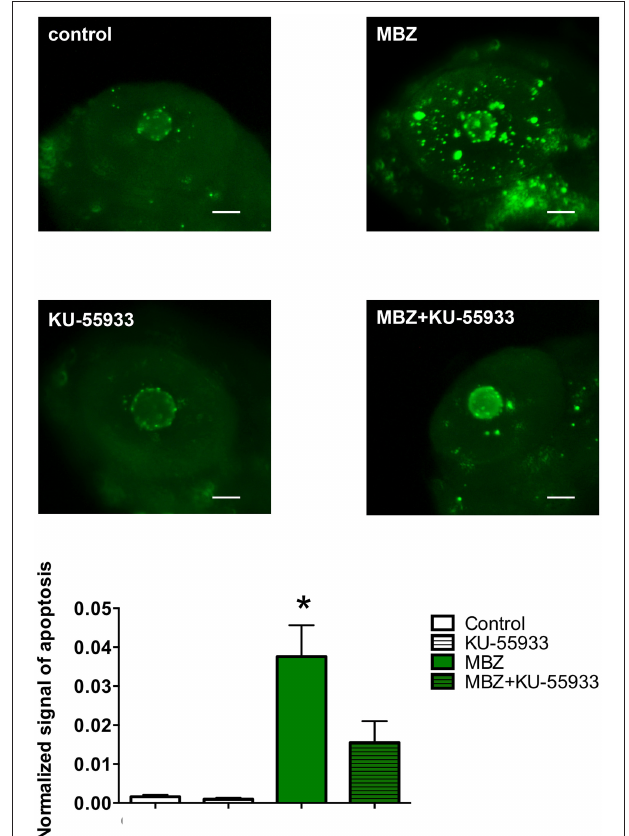
FIGURE 6 | Inhibition of ATM attenuated apoptosis induced by MBZ in the zebrafish retina. Zebrafish were exposed to 0.5 µ M MBZ or 0.1% DMSO with or without 2 µ M KU-55933 from 2 to 3dpf. After exposure, zebrafish were subjected to TUNEL staining. The areas of apoptotic signal in the retina were measured and normalized by the area of retina. n = 8 per each group except for 0.1% DMSO and 2 µ M KU-5593 ( n = 5 ). * p < 0.05 compared with control. Scale bar: 50 µ